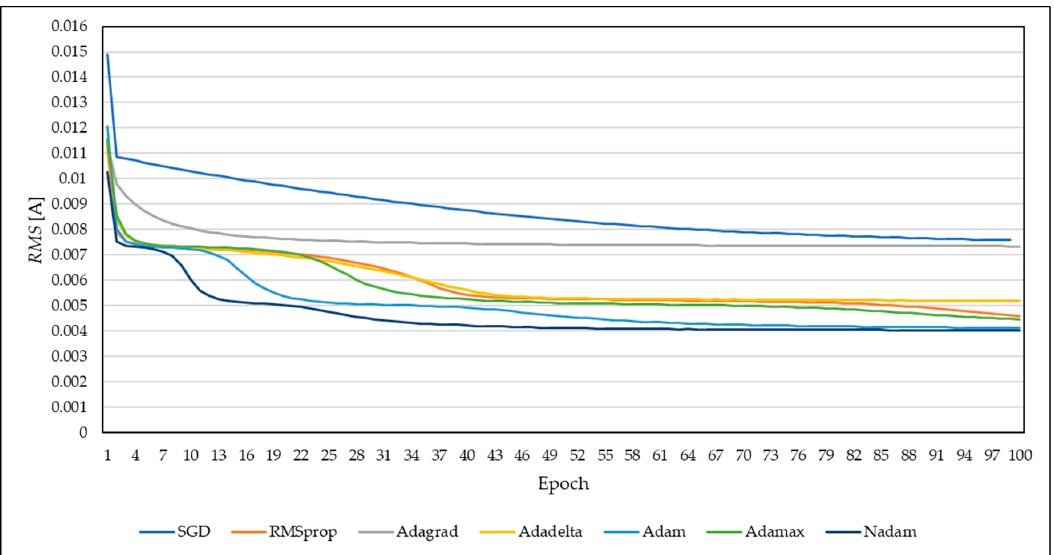
Figure 13. The mean squared error ( MSE ) of the artificial neural network (ANN) training for different types of optimizers.